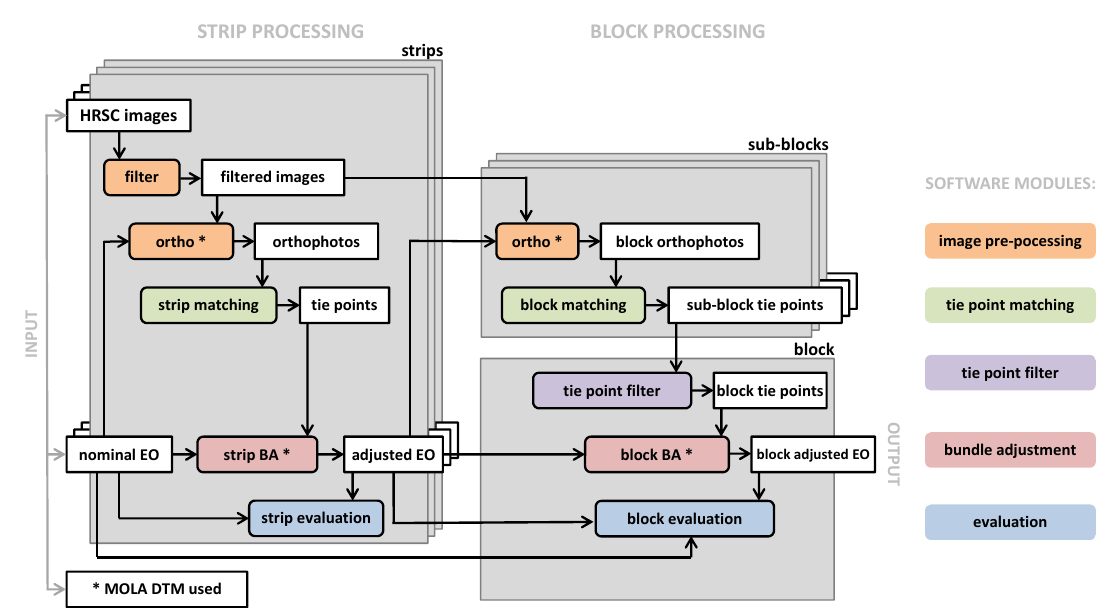
Figure 3: Process for the bundle adjustment of HRSC image data